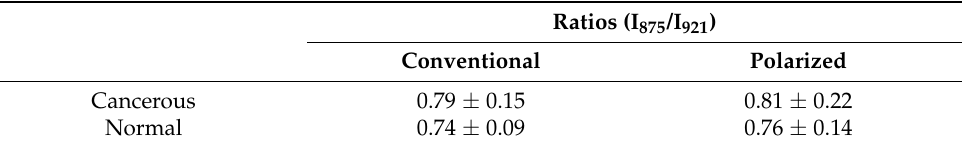
Table 8. Characteristic intensity of the integral area ratios of proline and hydroxyproline in cancerous and normal